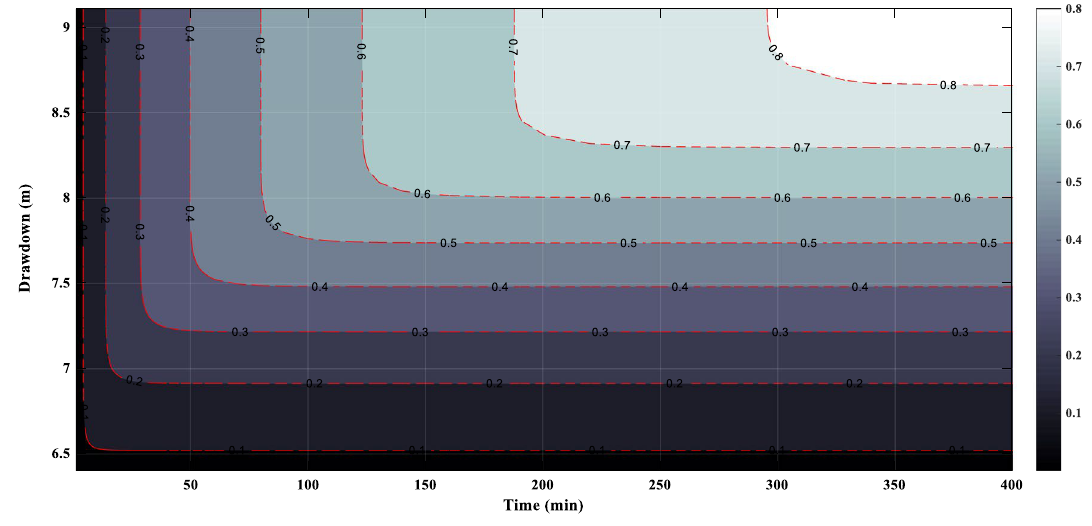
Fig. 9 Contour lines with a cumulative probability of both groundwater drawdown and pumping time for pumping test with a discharge of 28.8